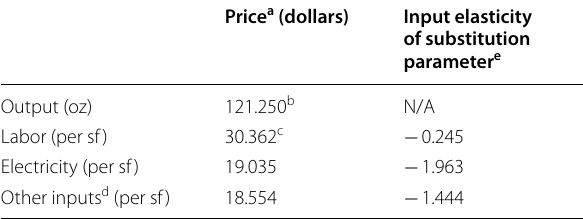
Table 2 Output price, input prices, and corresponding elasticity parameters of cannabis